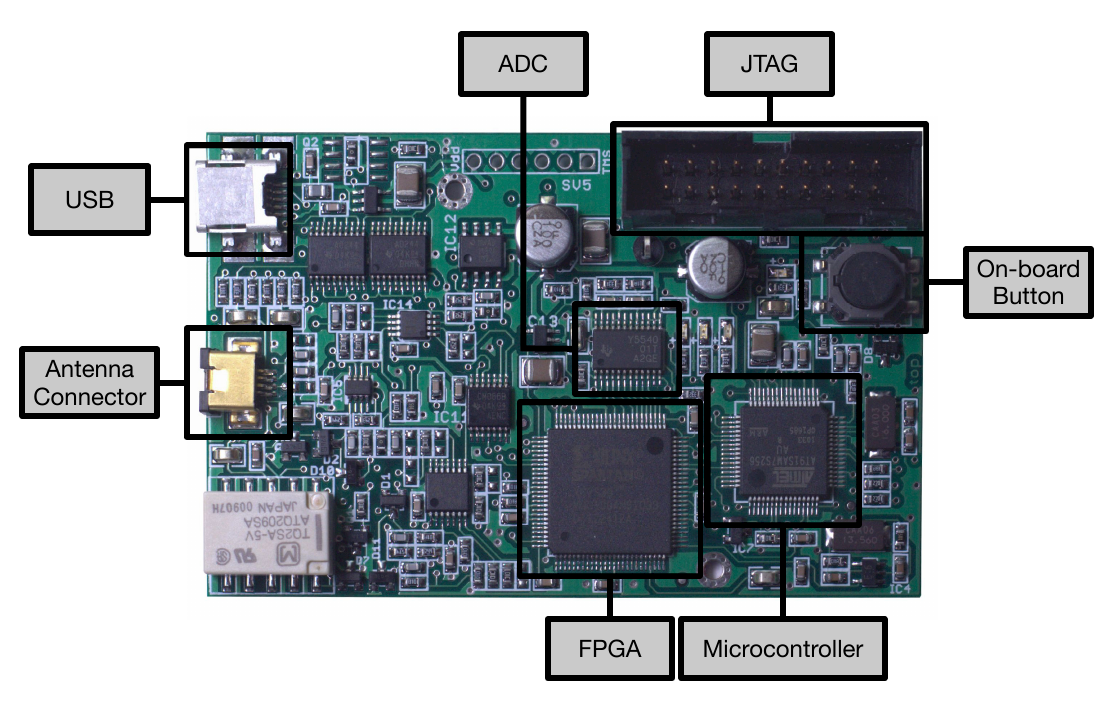
Figure 2. Main components of Proxmark